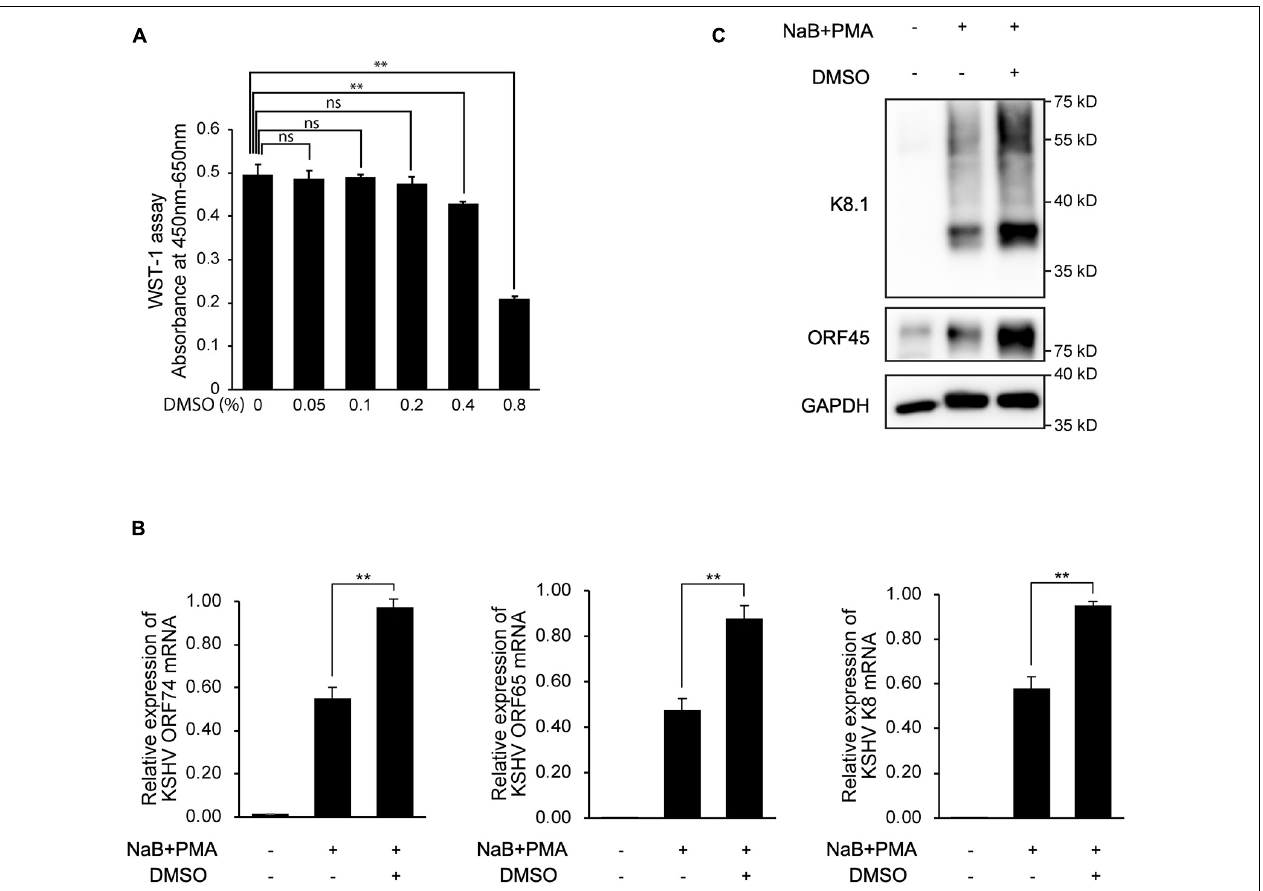
FIGURE 4 | Enhanced expression of KSHV lytic genes in BCBL-1 cells by DMSO during reactivation. (A) Cell viability with various concentrations of DMSO. After 24 h of DMSO treatment, cell viabilities were analyzed by WST-1 assay. Data are shown as the mean ± SD, n = 3, ns, not significant; ** p < 0.01. (B) RT-qPCR analysis of mRNA expression of KSHV viral genes. Reactivation of KSHV was induced in BCBL-1 by treatment with sodium butyrate (NaB, 0.3 mM) and phorbol-13-acetate (PMA, 20 ng/mL). DMSO (0.2%) was treated at the beginning of reactivation. RNA or protein lysate was extracted at 48 h after induction of lytic replication. Data are shown as the mean ± SD, n = 3, and ** p < 0.01. (C) Western blot analysis of KSHV ORF45 and K8.1 in BCBL-1